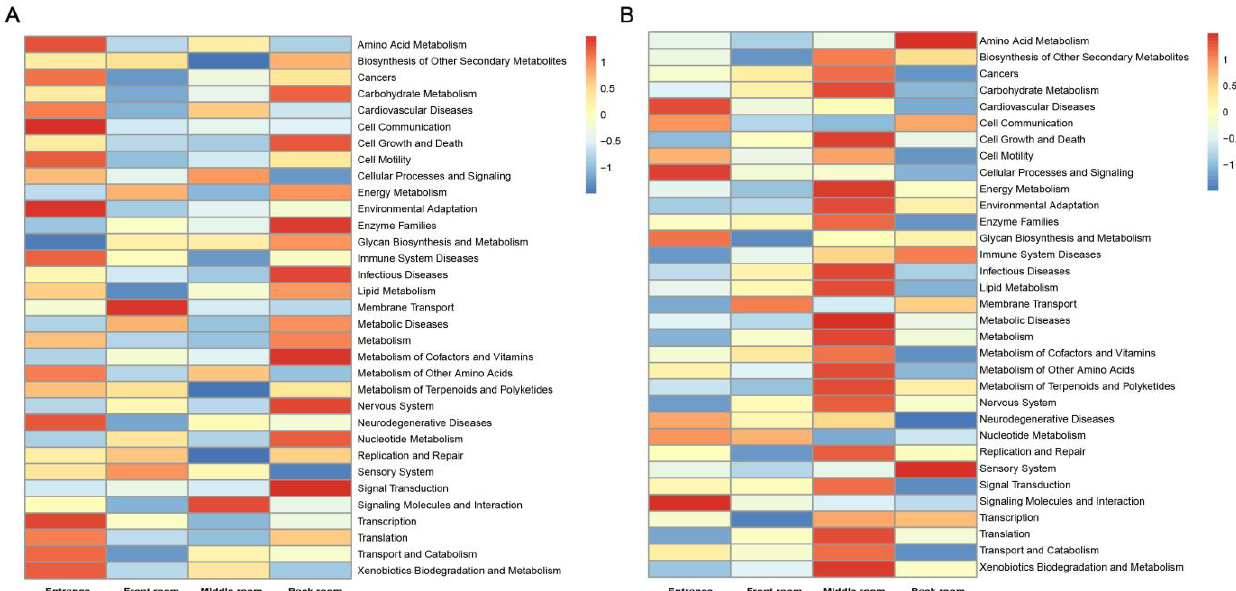
Figure 6. Heat map of the KEGG level-2 functional pathways for communities on bricks among the entrance, front, middle and back rooms in Shunling ( A ) and Qinling Mausoleums ( B ). The normalized relative abundance of each KEGG pathway is indicated by a gradient of color from blue (low abundance) to red (high abundance).